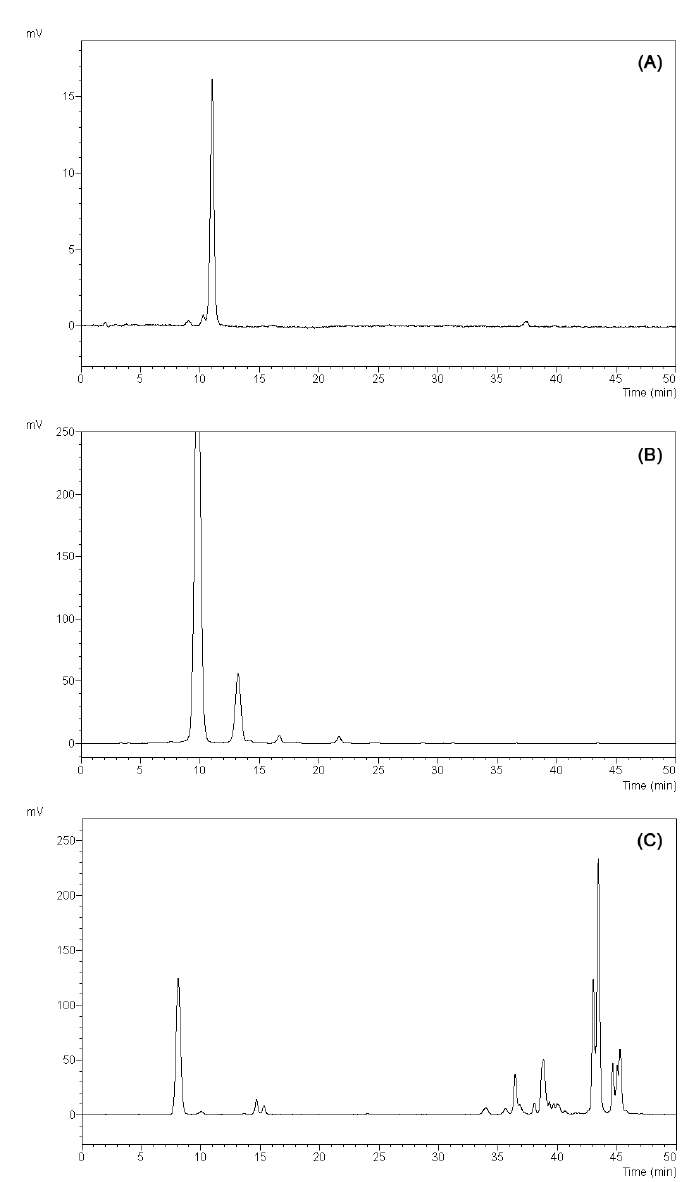
Figure 5. HPLC-UV/Vis chromatograms acquired at 520 nm of ( A ) blue hortensia, ( B ) red rose and ( C ) red cabbage anthocyanins